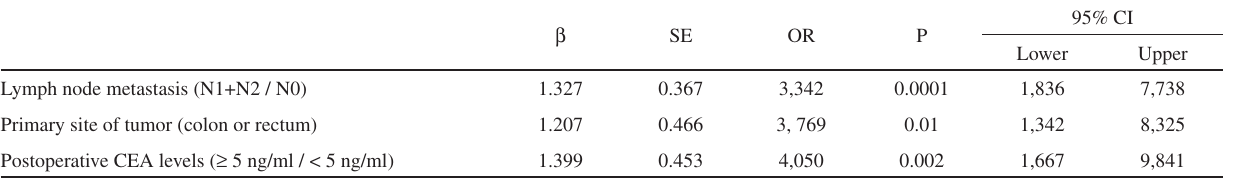
Table 5 - Multivariate analysis of factors releated to recurrence in CRC